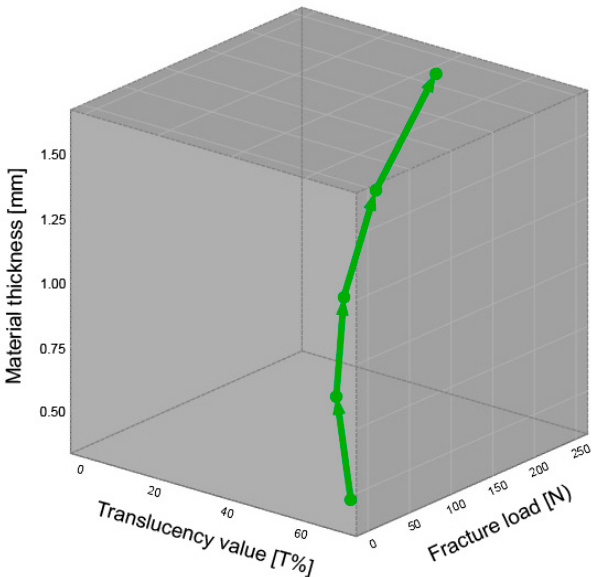
Figure 8. Three-dimensional regression curve of IPS Empress CAD LT A2 for the translucency,